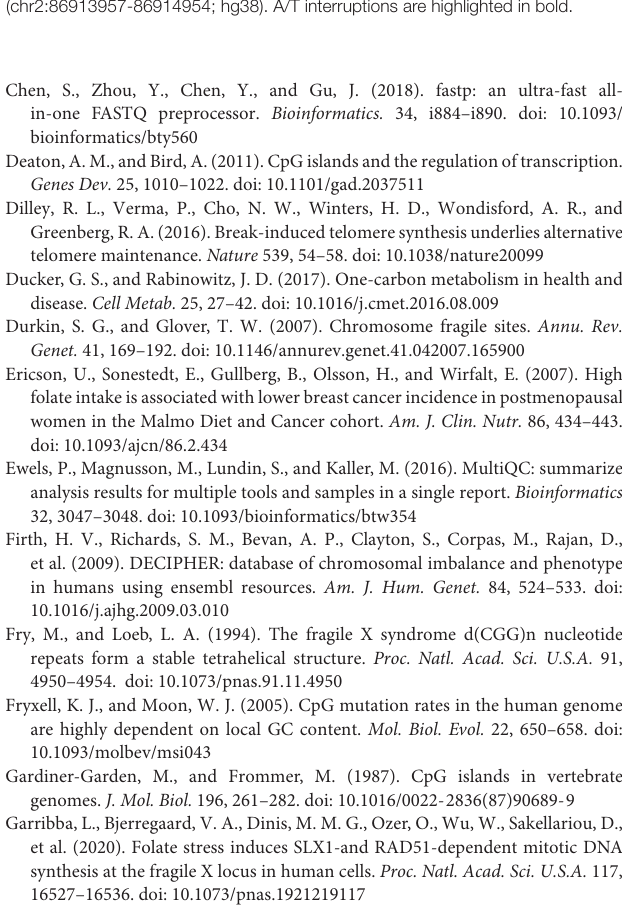
Supplementary Table 4 | A summary of the polymorphisms at FOLD1 (chr2:86913957-86914954) present in the general population. Supplementary Table 5 | A summary of the mutations in patient reported in DECIPHER database containing FOLD1 (chr2:86913957-86914954) (DECIPHER: